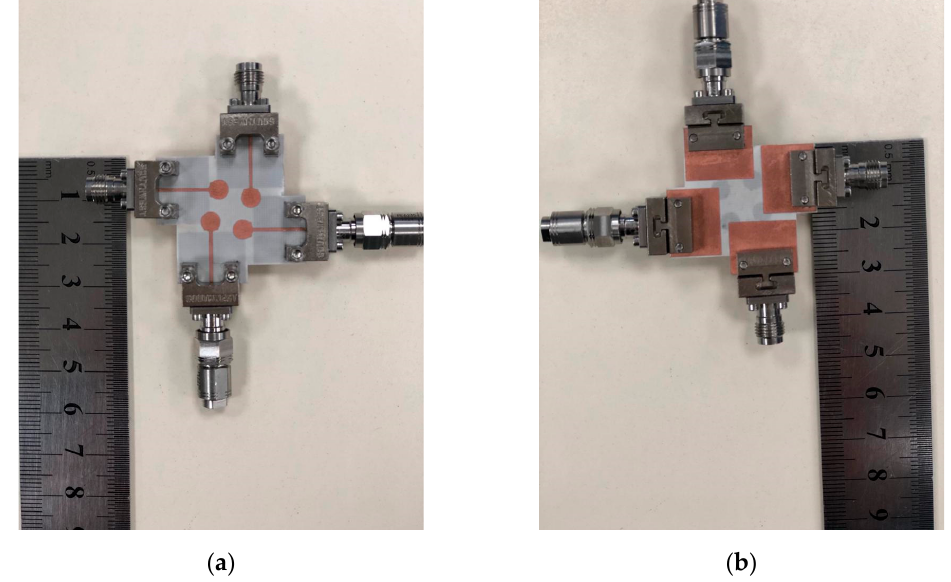
Figure 2. The fabricated prototype of 4 elements MIMO antenna ( a ) Top View ( b ) Bottom view.